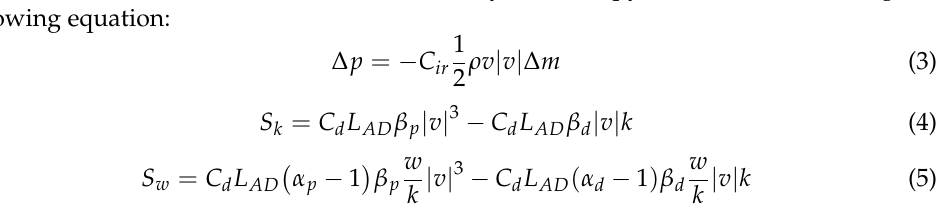
Figure 3. Pressure loss coefficient distribution within the canopy.